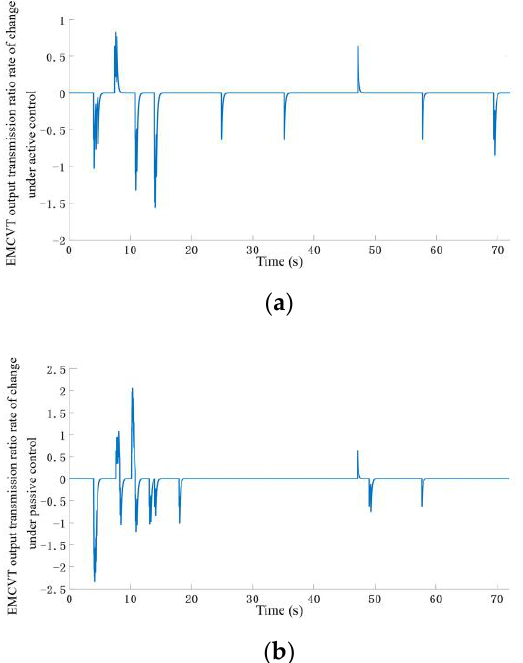
Figure 16. EMCVT output transmission ratio change rate: ( a ) EMCVT output transmission ratio rate of change under active control; ( b ) EMCVT output transmission ratio rate of change under passive control.